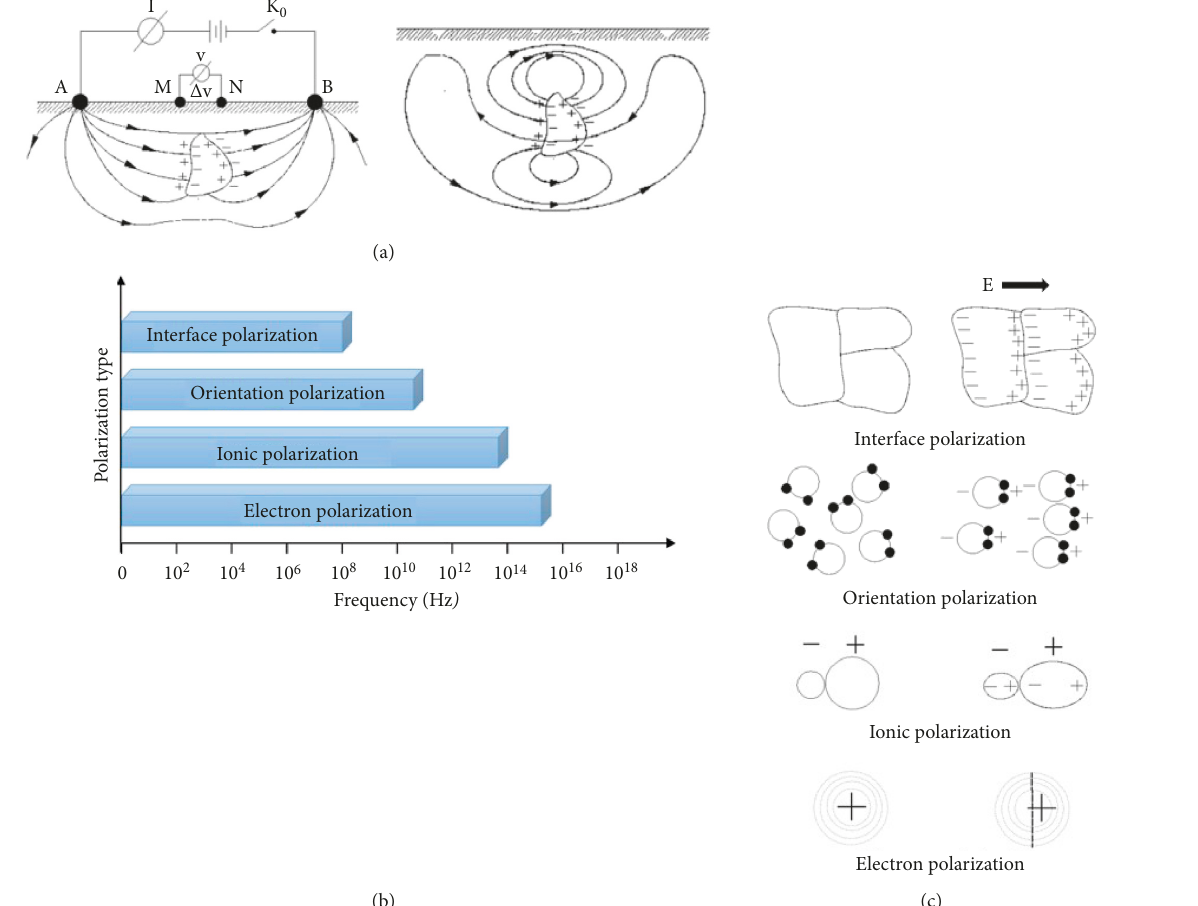
Figure 4: Polarization mechanism of coal under applied electric field: (a) induced polarization, (b) polarization relaxation time, and (c) polarization